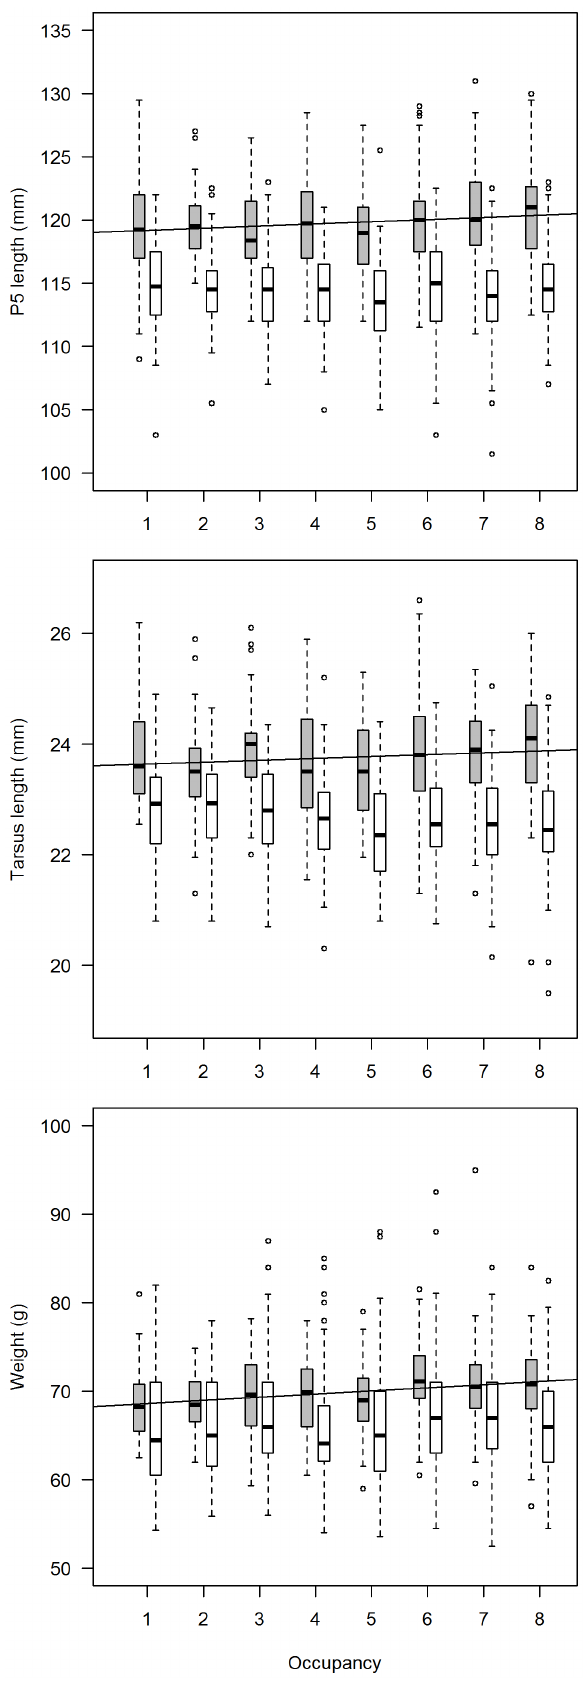
Figure 2. Relationship between territory occupancy and individual characteristics. Relationship between territory occupancy (2002–2009) vs. P5 (fifth primary feather) length, tarsus length and body mass of territory occupants. Males: grey bars; females: white bars. The regression lines refer to males for which trends were statistically